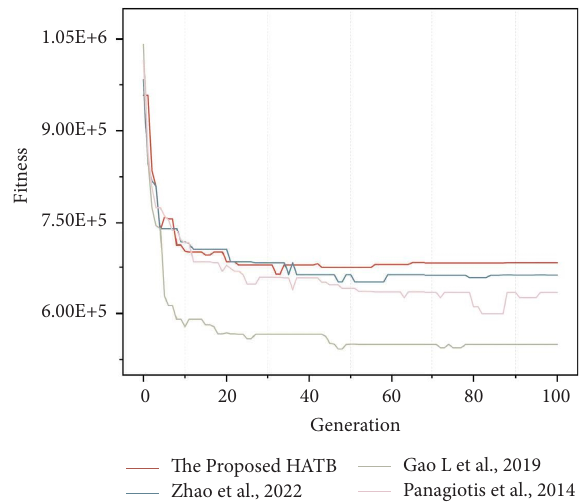
Figure 4: Te comparison between diferent scheduling